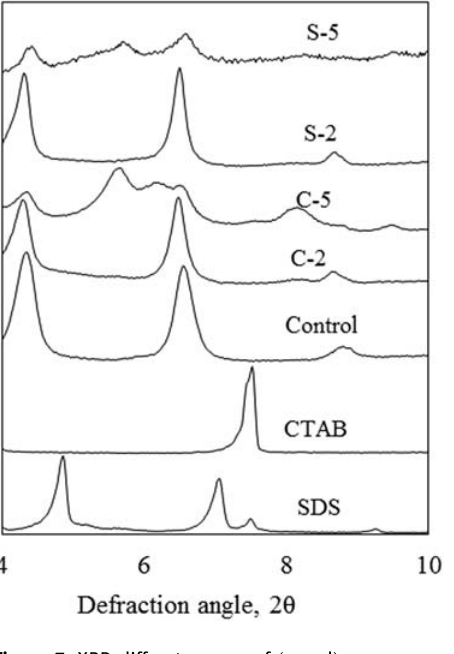
Figure 7: XRD di ff ractograms of ( cured ) nanocomposites.